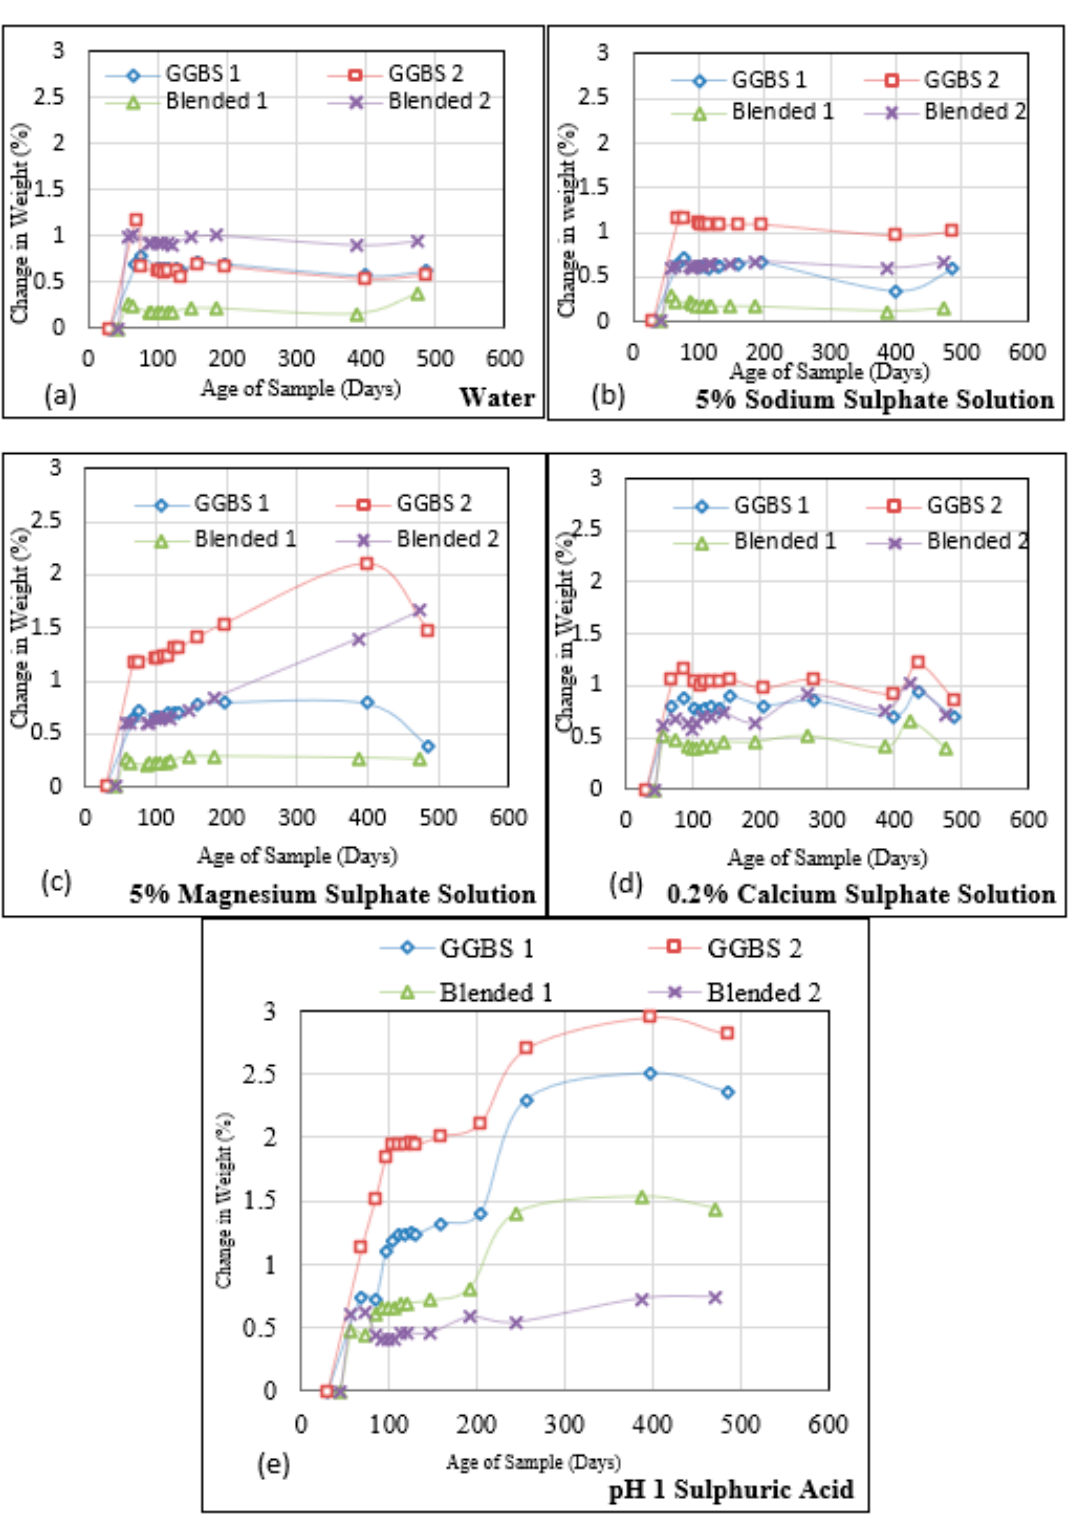
Figure 7. Change in weight of Group 1 AASC and AAS/F concrete mixes (cured for 28 days before exposure) during immersion in different solutions [( a ) Water, ( b ) Na 2 SO 4 , ( c ) MgSO 4 , ( d ) CaSO 4 , ( e ) H 2 SO 4 -pH 1].